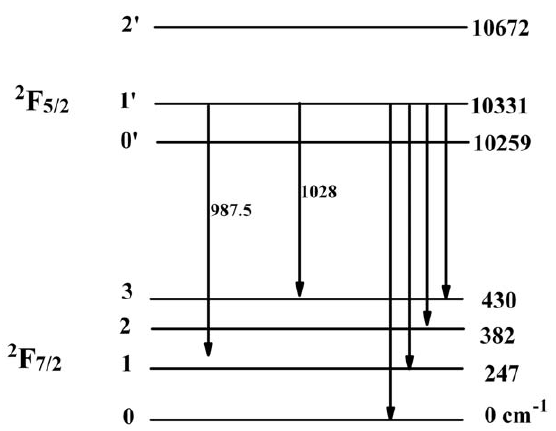
Figure 10. Stark energy-level diagram of the 2 F 5/2 and 2 F 7/2 manifold of Yb 3 + in KBaGd(MoO 4 ) 3 crystal.